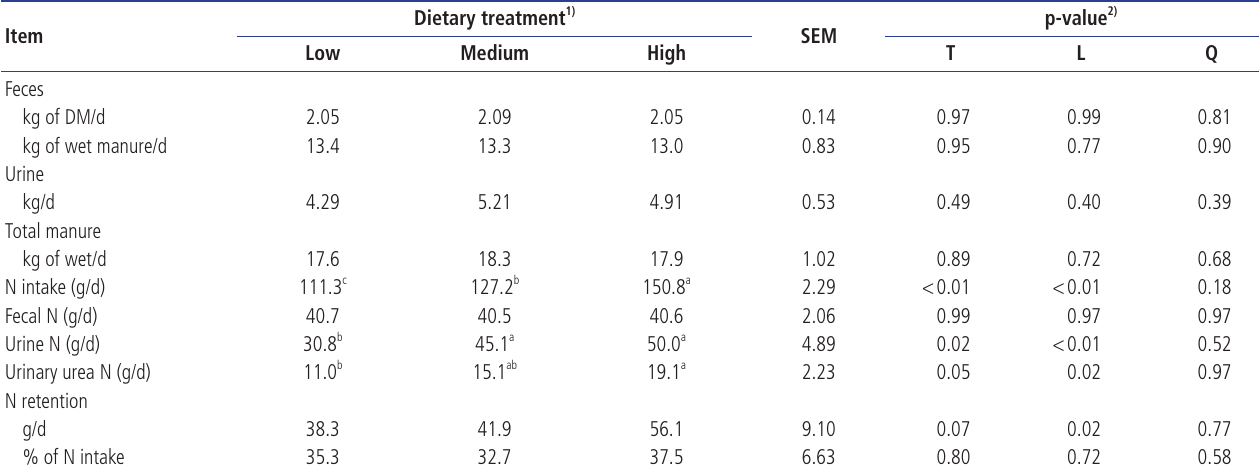
Dietary treatment 1)